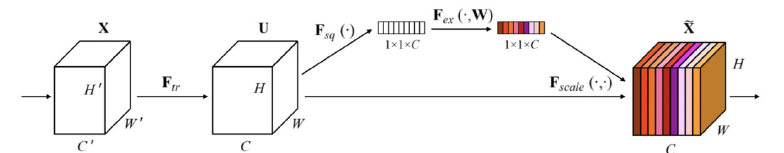
Figure 3. The structure of SE-block